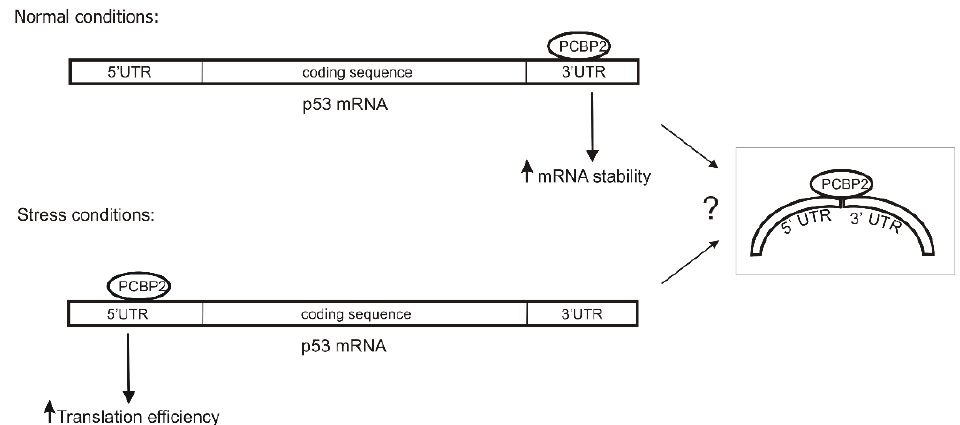
Figure 8. Model of the regulation of p53 expression with the involvement of PCBP2 interacting with the 5 ′ and 3 ′ ends of p53 mRNA. Under normal conditions, PCBP2 increases the stability of p53 mRNA, probably via the interactions with the 3 ′ UTR, while in the presence of stress factors PCBP2 binds to the 5 ′ terminus of p53 mRNA modulating p53 translation. PCBP2 is likely to bind to both ends of p53 mRNA simultaneously under stress conditions, which resembles the interactions with viral RNAs (grey box).